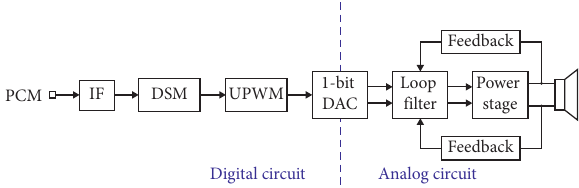
Figure 2: Block diagram of the proposed class-D